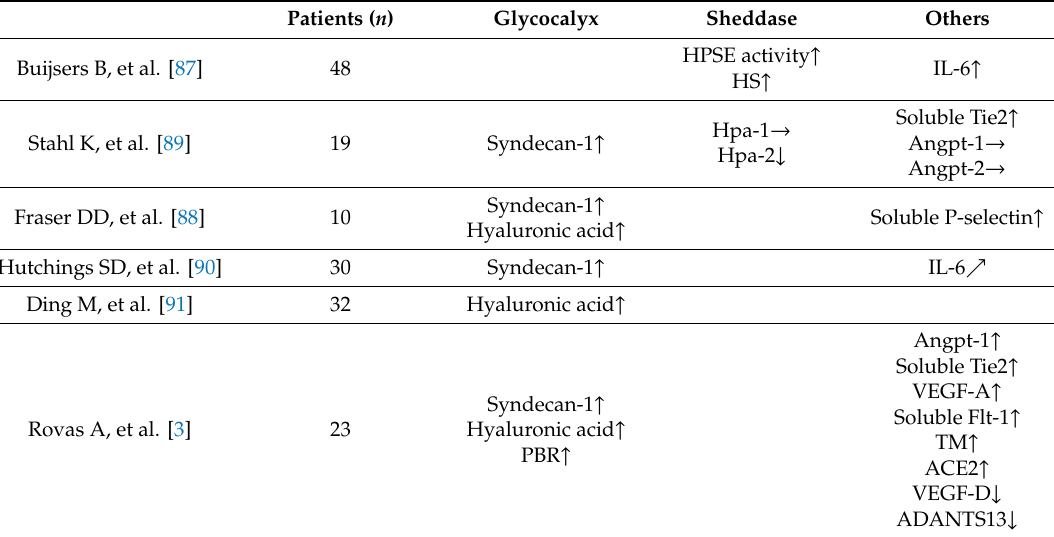
Table 3. VEGLX in patients with